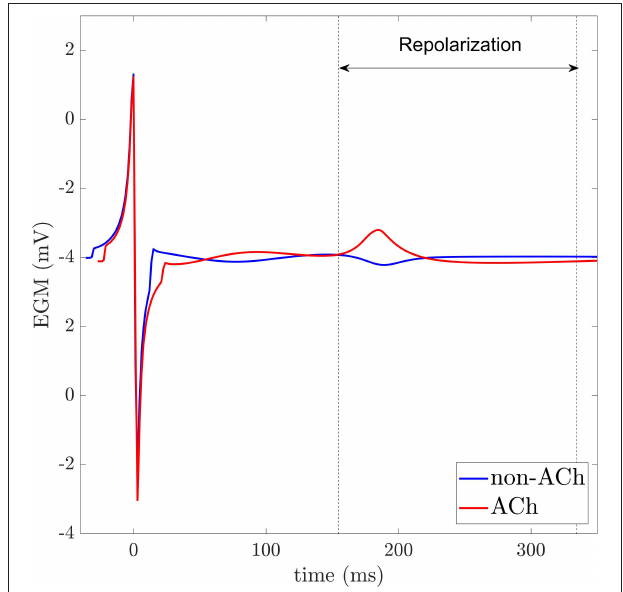
FIGURE 3 | (A) 2D model of a non-atrial fibrillation (AF) tissue with ACh release sites shown in black and EGM electrodes in red and blue. (B) APs and EGMs were recorded in the ( i , j ) points represented in the left panel. The thicker lines correspond to the points represented with big squares in the tissue.